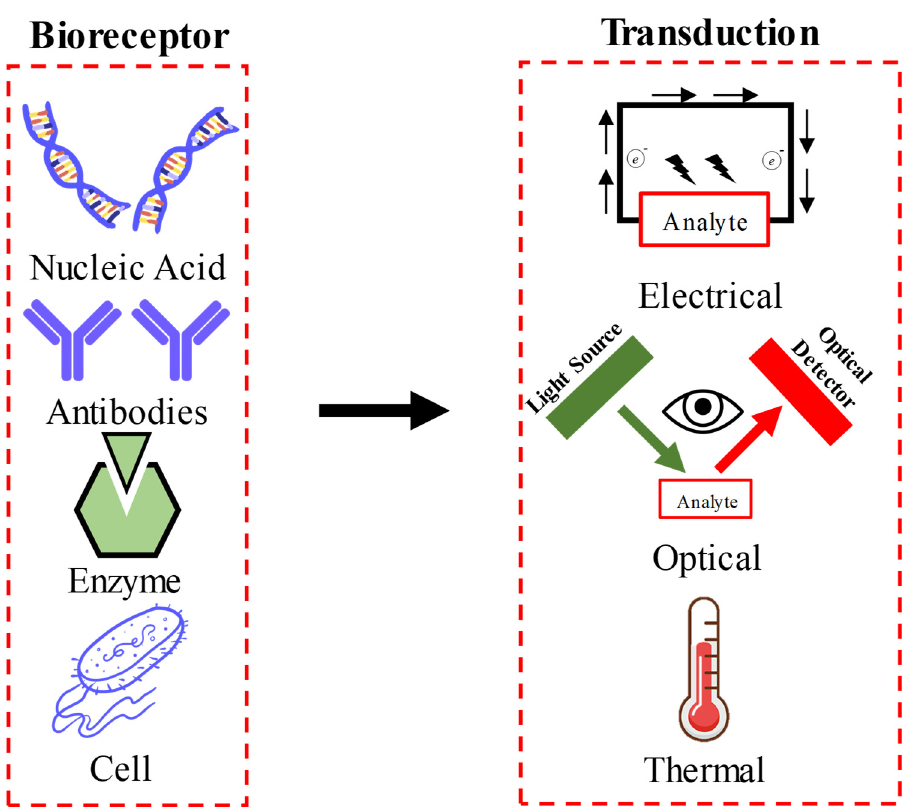
Figure 1. Schematic showing the working principle of biosensors based on different methods of transduction.